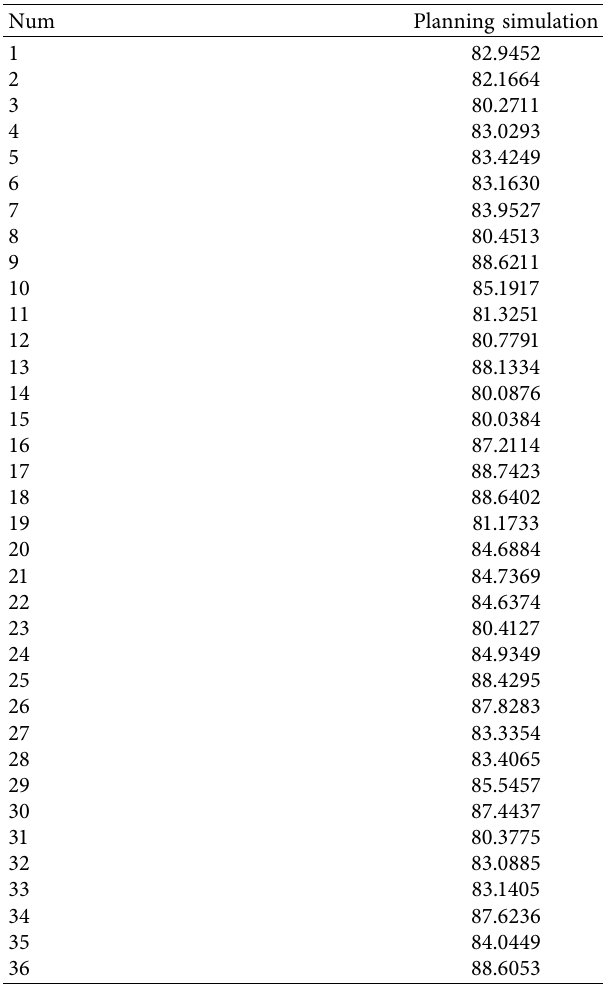
Table 1: Planning effect of the development path of sports wellness town.